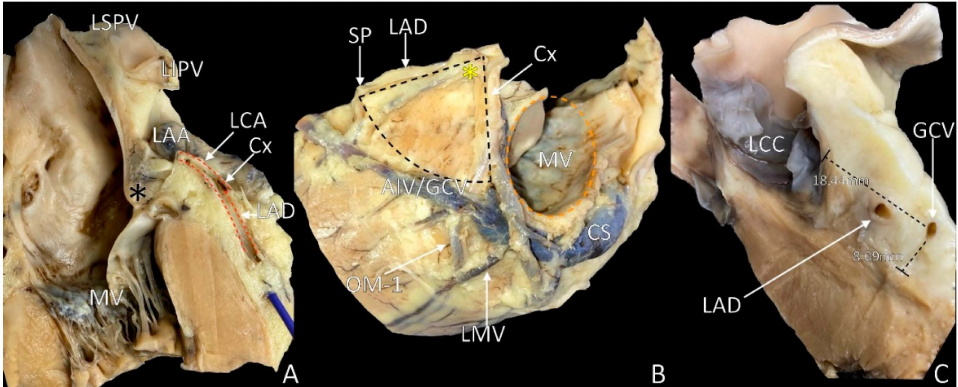
Figure 2. Photographs of cadaveric heart specimens showing the left ventricular summit (LVS) area with overlying epicardial adipose tissue. ( A ) Section through the septal margin of the LVS; ( B ) view of the LVS after adipose tissue removal; ( C ) section through the LVS showing the abundance of the adipose tissue. Black asterisk = aortic–mitral continuity, yellow asterisk = apex of LVS, AIV = anterior interventricular vein, CS = coronary sinus, Cx = circumflex branch of left coronary artery, GCV = great cardiac vein, LAA = left atrial appendage, LAD = left anterior descending artery, LCC = left coronary cusp, LIPV = left inferior pulmonary vein, LMV = left marginal vein, LSPV = left superior pulmonary vein, OM = obtuse marginal branch, MV = mitral valve, SP = septal